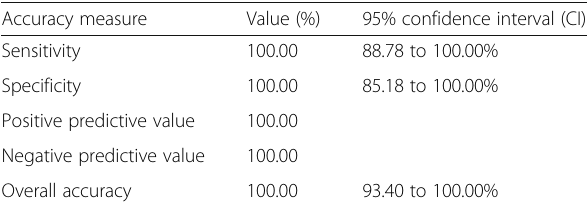
Table 4 The accuracy measures for the high-resolution ultrasound diagnosis Accuracy